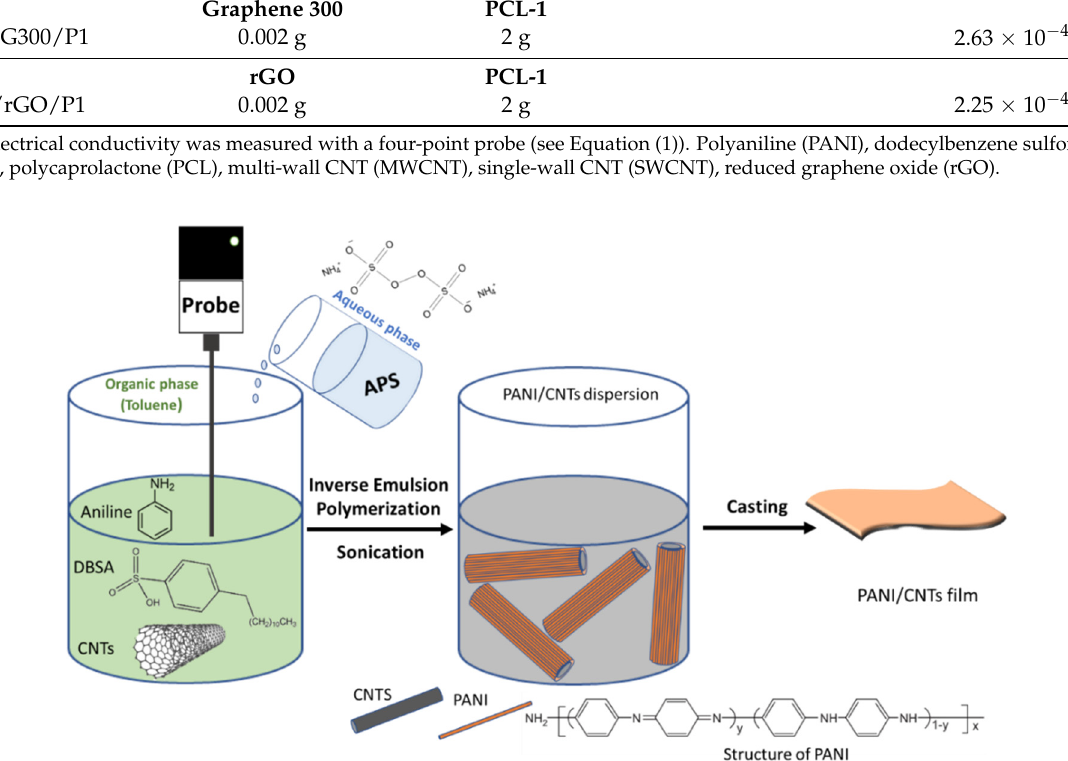
Figure 1. Inverse emulsion polymerization of aniline in the presence of CNTs for the fabrication of PANI/CNM